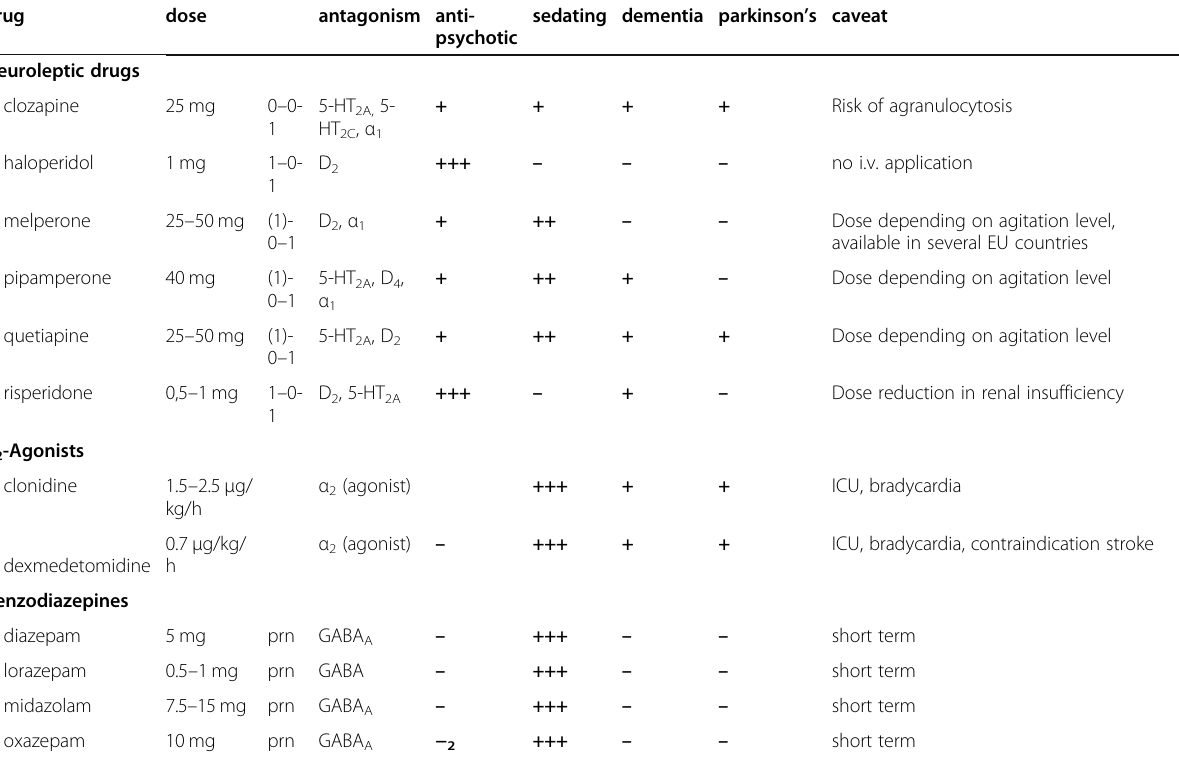
Table 2 Selected drugs for the treatment of delirium (in alphabetical order per class)